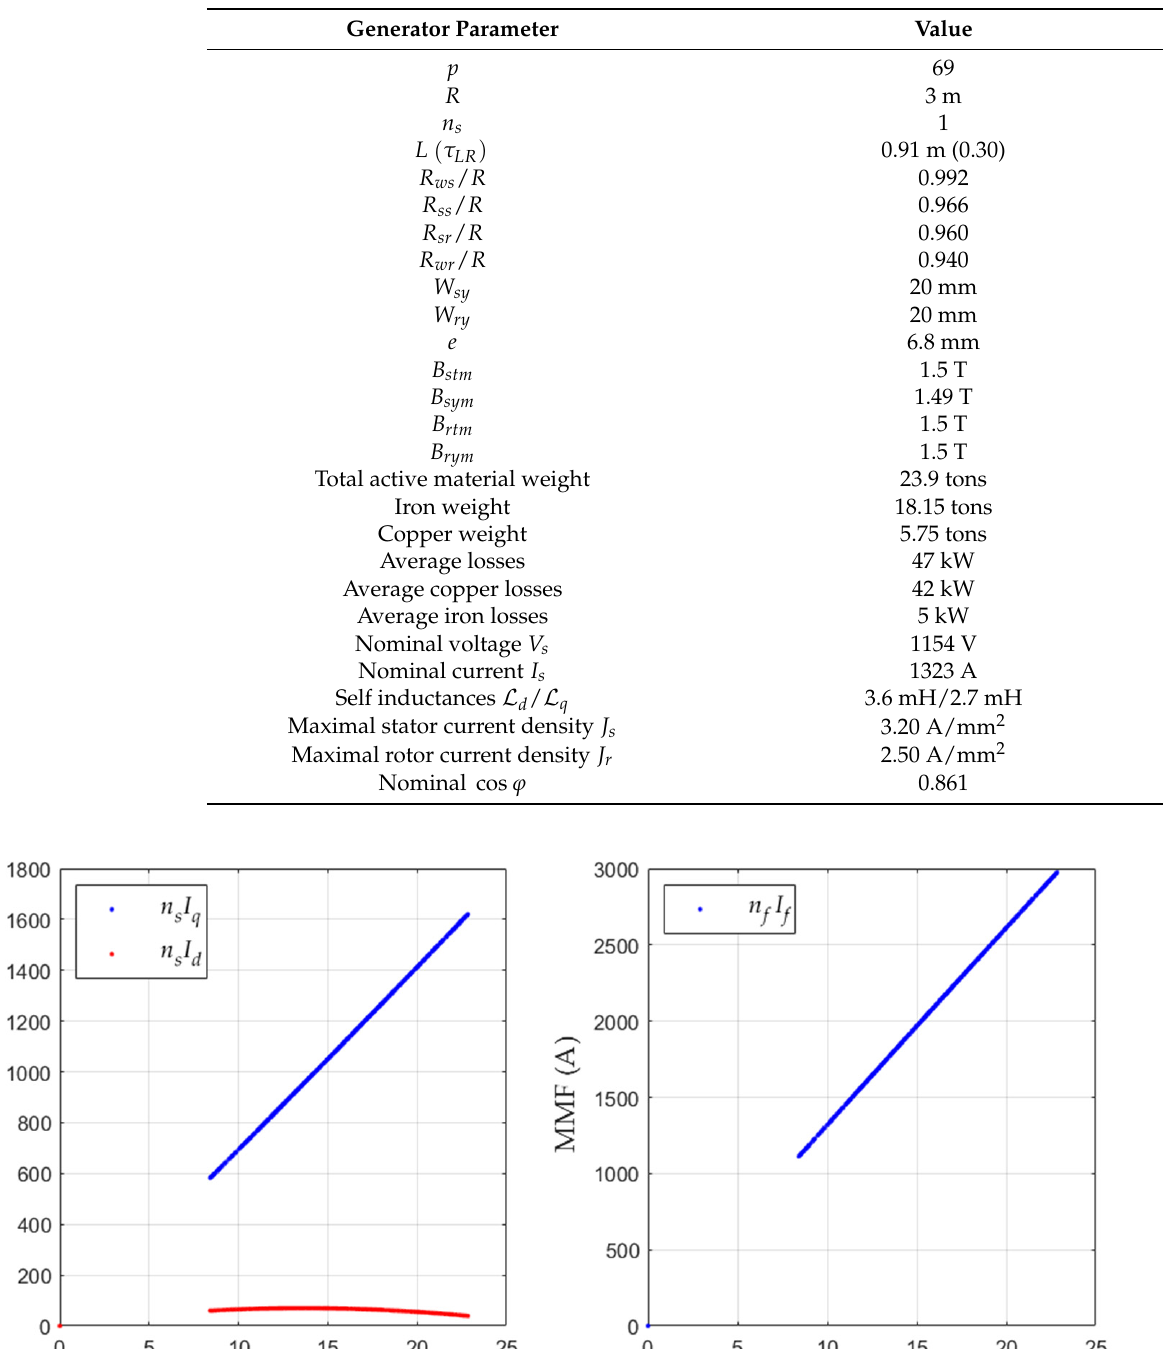
Table 3. Optimal generator parameters.